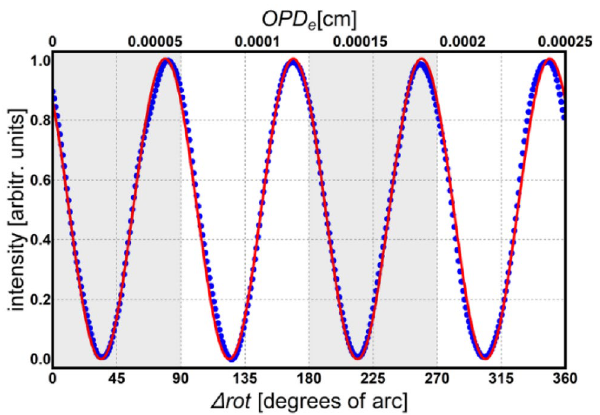
Figure 3. Calibration of the polarizing interferometer: blue dots—experimental data, red curve—theoretical model.